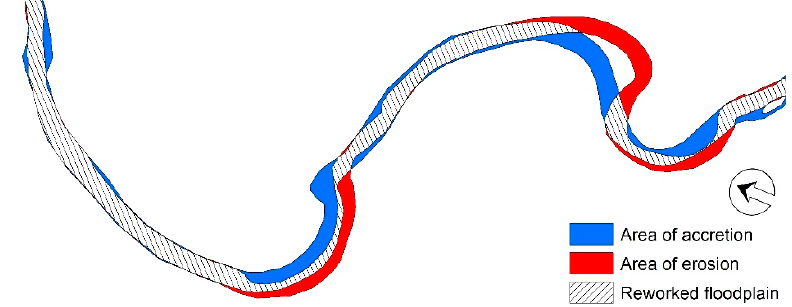
Figure 2. Methodology for calculating areas of erosion and accretion.